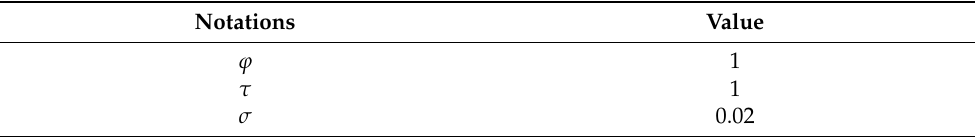
Table 4. Values of